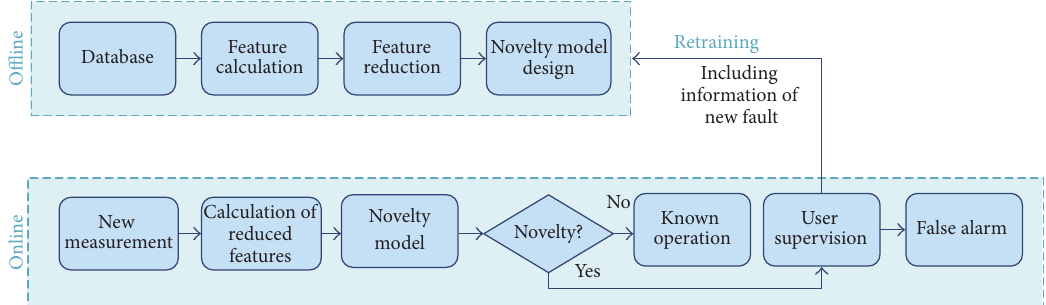
Figure 1: Proposed methodology for the novelty detection approach. The monitoring method is composed of an offline stage for initialization and retraining and an online stage for continuous